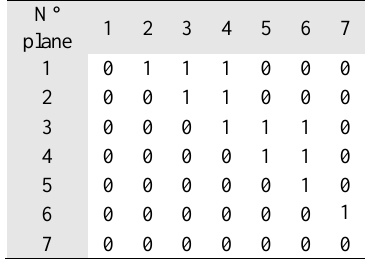
Table 2. plane_adjacent matrix of building shown in Figure 1e